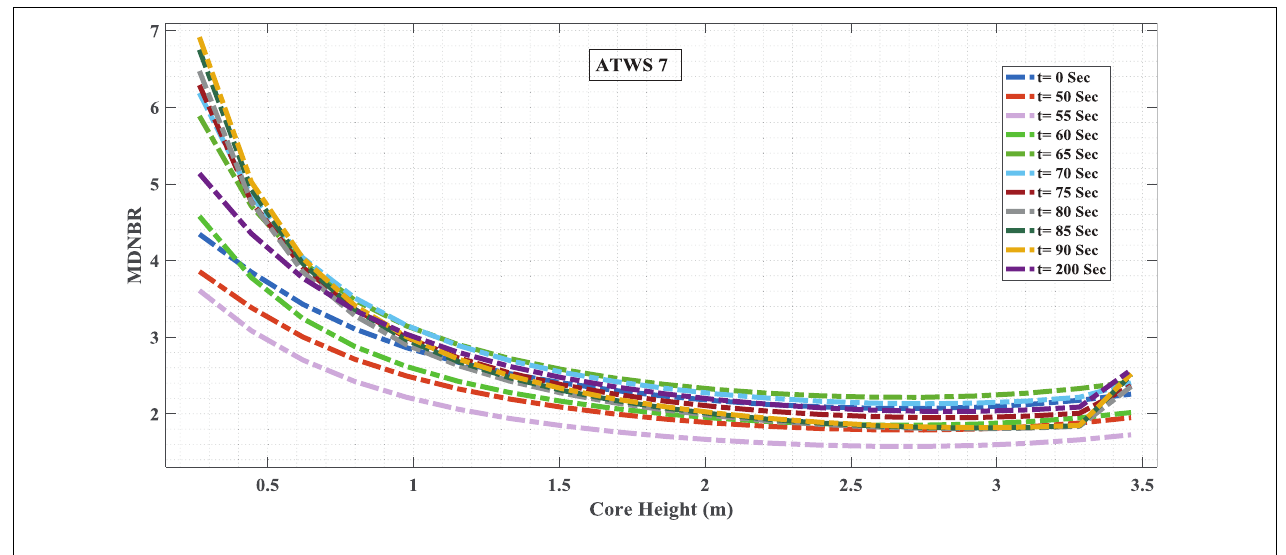
FIGURE 18 | MDNBR in core heights during ATWS 7.